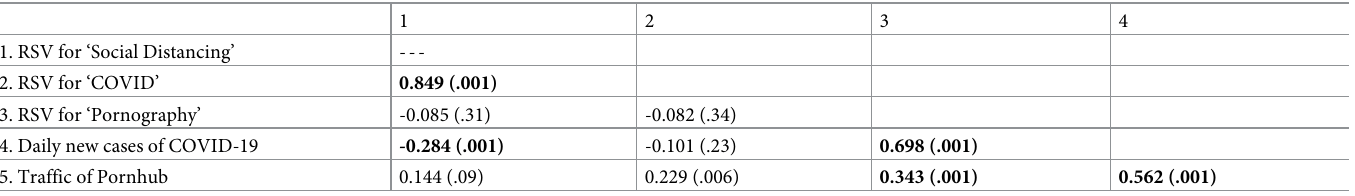
Table 1. Spearman’s rho correlation among studied variables.